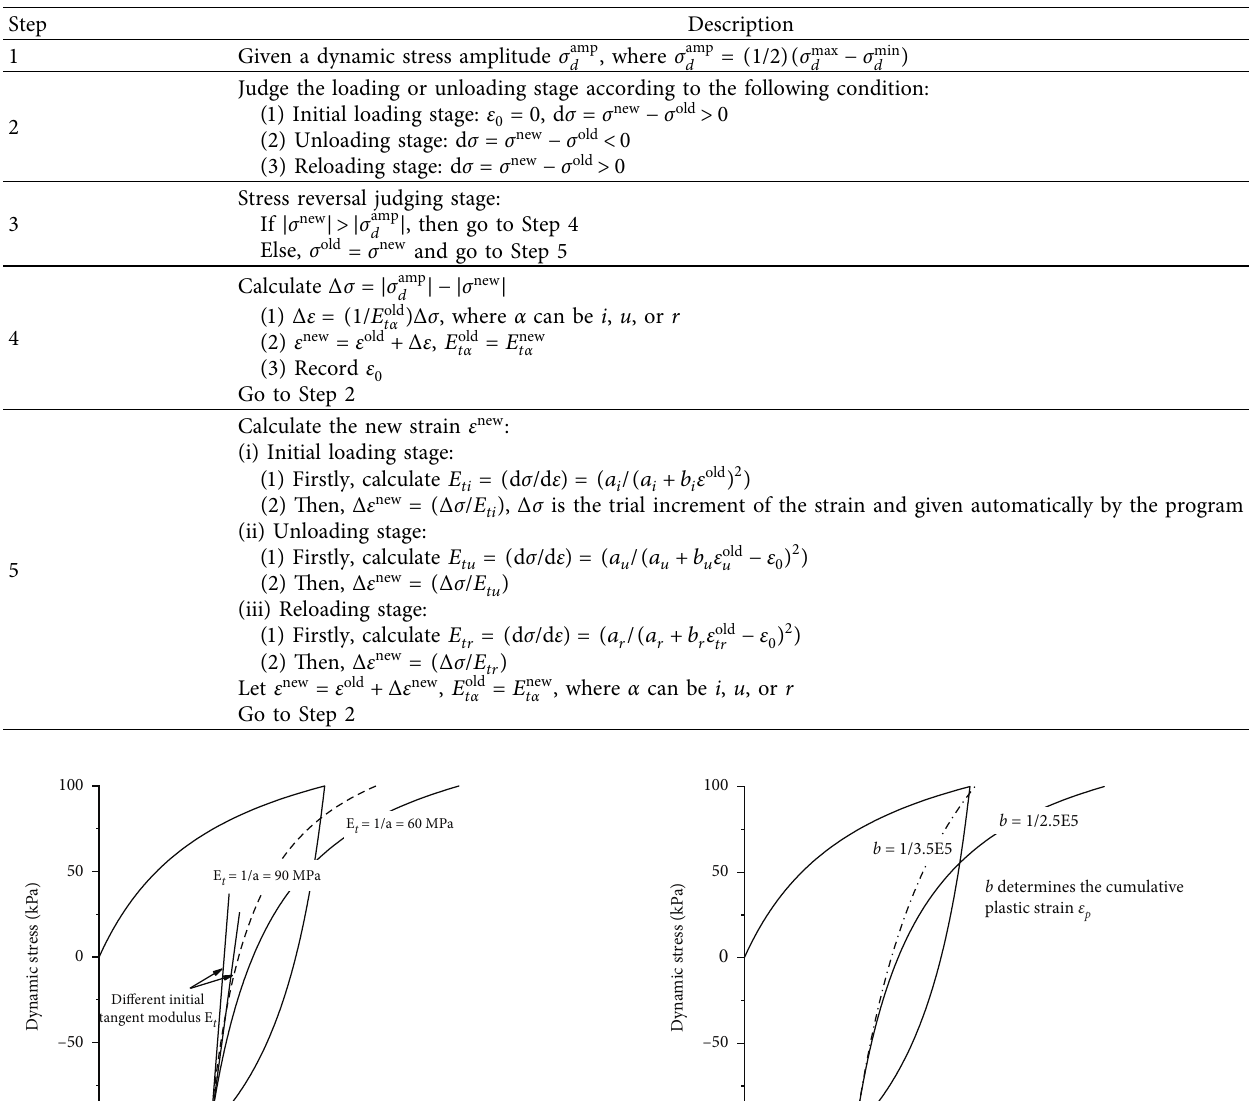
Table 1: The whole integration procedure.